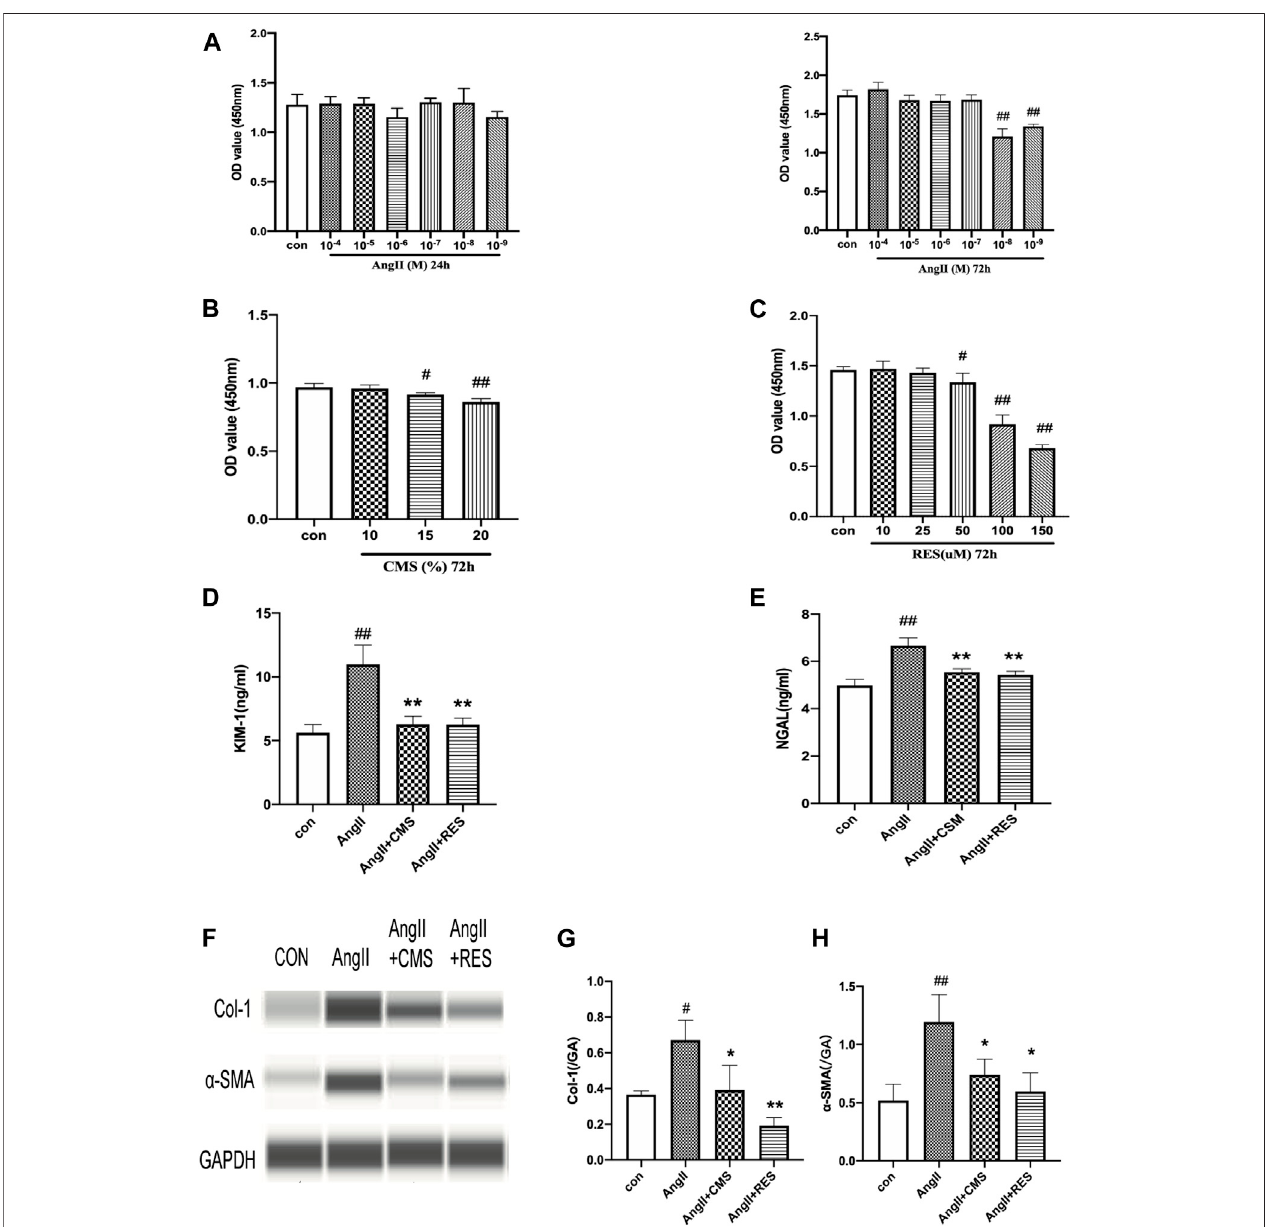
FIGURE2| CMSattenuatedAngII-associatedinjuryandinhibitedECMaccumulationinratrenaltubularepithelialcells. (A) NRK-52Ecellswereexposedtovarious concentrationsofAngIIfor24and72 h. (B) EffectsofCMSonviabilityfor72 h. (C) EffectsofRESonNRK-52Ecellviabilityfor72 h. (D , E) EffectofCMSonNRK-52Ecell injury. The level of cell injury was examined by KIM-1 and NGAL ELISA kits. (F) Effect of CMS on the expression of Col-1 and α -SMA. (G , H) The relative intensities of fi brosis-relatedproteinincellswerecalculatedafternormalizationagainstGAPDH.Dataareexpressedasthemean ± SDofthreeseparateexperiments. # p < 0.05, ## p < 0.01 compared with control cells. * p < 0.05, ** p < 0.01, compared with the model group.